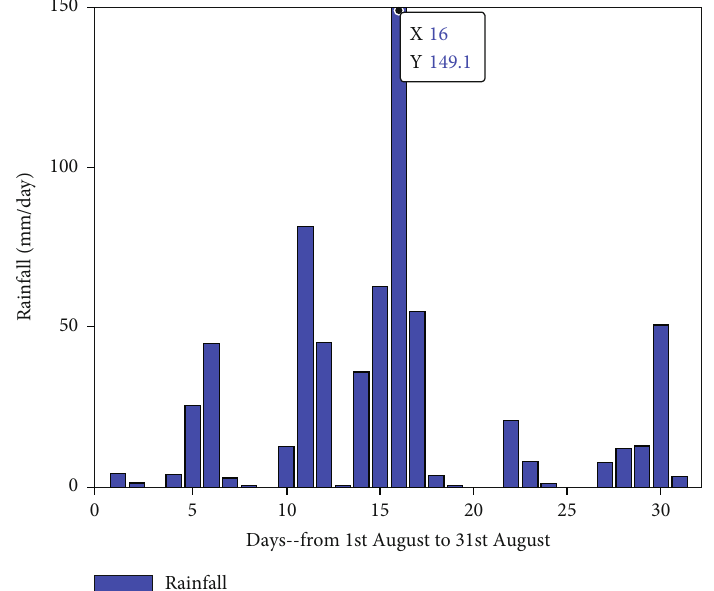
Figure 4: The precipitation data provided by Geoenvironment Monitoring Institute in